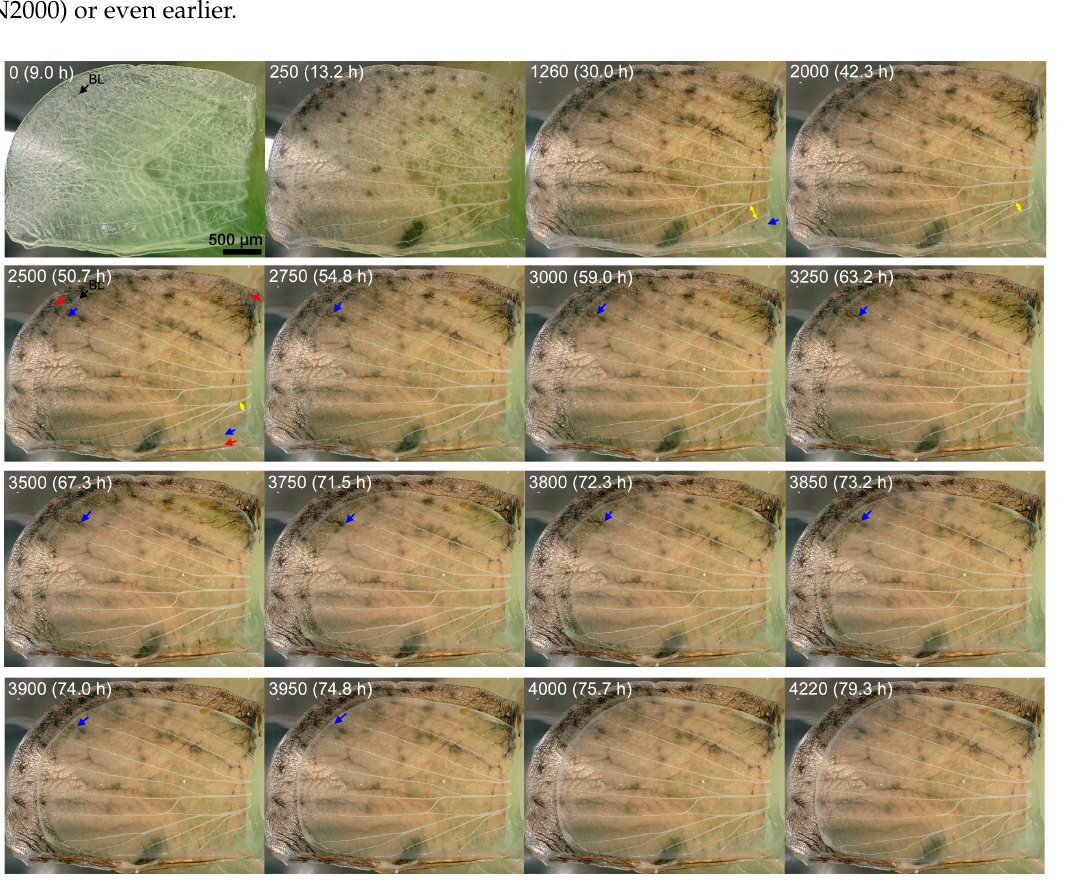
Figure 3. Dynamics of the pupal forewing. The forewing tissue was observed from the ventral side, distal to the left and anterior to the bottom. Image number and postpupation time are shown in each panel. Images were taken every 1 min and the first image taken was set at IN0. The image acquisition started at 9 h after pupation. The bordering lacuna (BL) is indicated in IN0. The edge of the ventral epithelium (blue arrows) and that of the dorsal epithelium (red arrows) are indicated. As an example, the distance between two tracheae is indicated by double-headed yellow arrows in IN1260–IN2500. Additionally, see Figures 4,5 and Video S2.